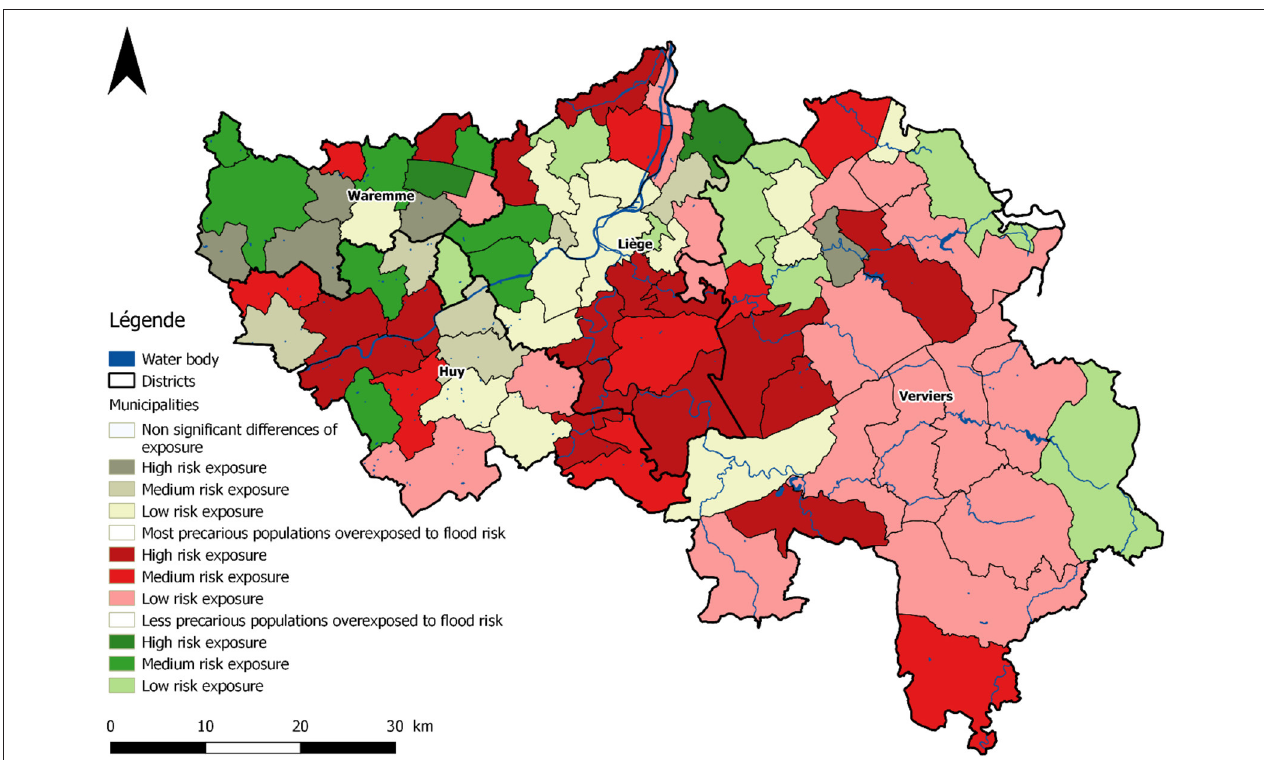
FIGURE 4 | Variation in the exposure to flood hazard between municipalities of the Province.